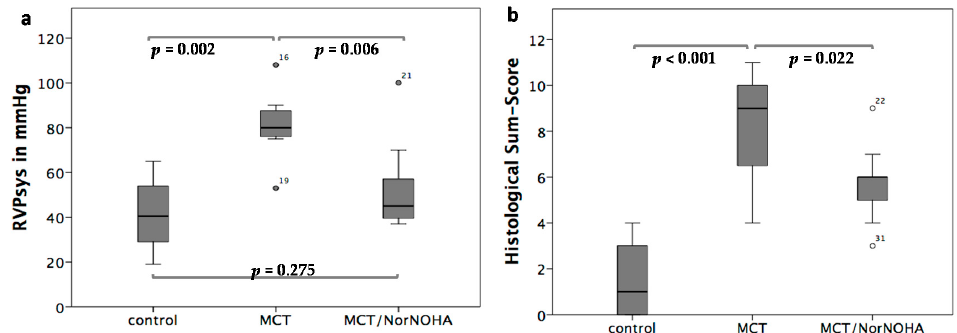
Figure 5. ( a ) Comparison of haemodynamic treatment effects of the Arginase inhibitor nor-NOHA: significant increase of RVPsys values in the MCT compared to the control group ( p = 0.002), decreased RVPsys values in the MCT/nor-NOHA compared to the MCT group ( p = 0.006) and non-significantly elevated RVPsys values between the MCT/NorNoha and the sham-treated control group ( p = 0.275). Data are presented as means and SD; ( b ) comparison of treatment effects of the Arginase inhibitor nor-NOHA with respect to lung tissue remodelling: the sham-treated control group showed healthy lung tissue, the MCT group exhibited distinct signs of lung damage ( p < 0.001 compared to the control group), which were diminished in the MCT/nor-NOHA group ( p = 0.022 compared to the MCT group). Data are presented as means and SD.